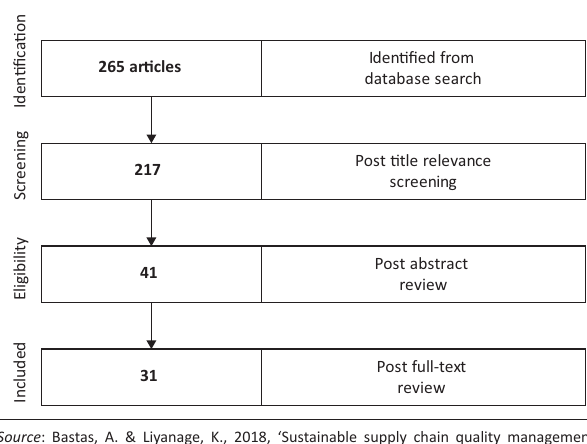
FIGURE 1: An overview of the article selection